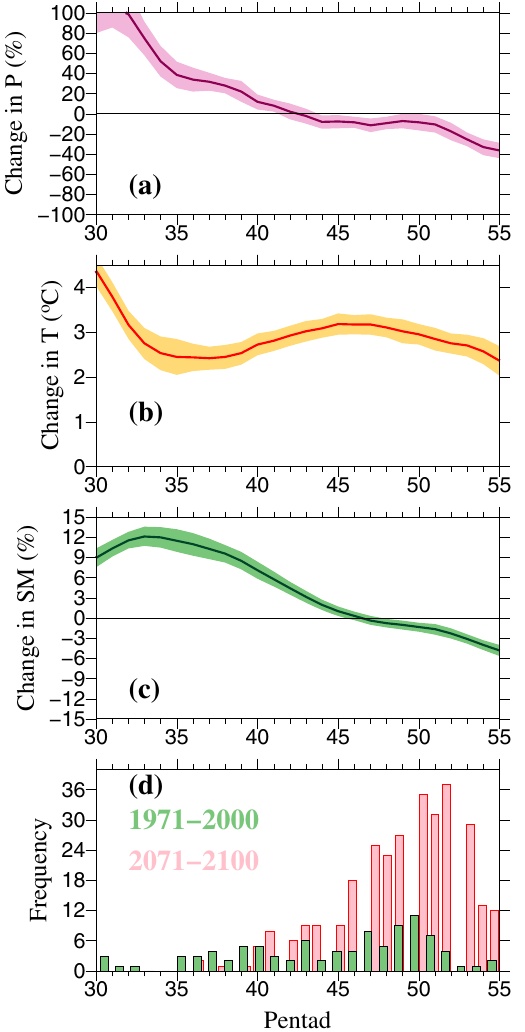
Fig. 5 Projections of precipitation, air temperature, soil moisture, and frequency of fl ash droughts during the monsoon season from CESM-LENS ensemble. a projected change in precipitation (%) for the pentads during the monsoon season, b same as a but for air temperature, c same as a but for soil moisture. Projected changes in the end of 21st century (2071 – 2100) was estimated against the reference period of 1971 – 2000. Shaded area in a – c shows the uncertainty (estimated using one standard deviation) based on the 40 ensemble members from CESM-LENS. d The frequency of fl ash droughts that occurred during the monsoon season for 1971 – 2000 and 2071 – 2100